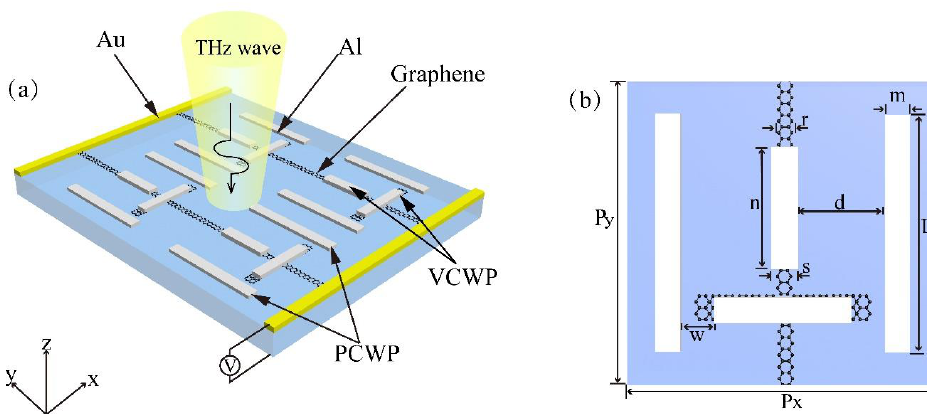
Figure 1. ( a ) The schematic of a hybrid metal–graphene metamaterial under a plane wave incident in the x -polarization direction; ( b ) detailed structural parameters of metamaterials: P x = 80 µm, P y = 120 µm, L = 60 µm, m = 5 µm, w = 4.5 µm, n = 42 µm, s = 4 µm, r = 1 µm, d = 23.5 µm perpendicularly.